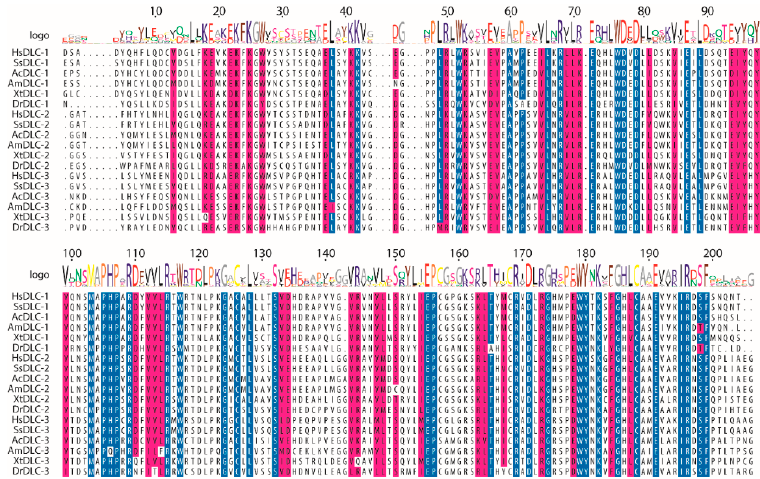
Figure 2. Representative subset of the multiple sequence alignment (MSA) of StAR-related lipid transfer (START) domains from DLC-1, DLC-2, and DLC-3 orthologs. Species include Homo sapiens (Hs), Sus scrofa (Ss), Aquila chrysaetos (Ac), Alligator mississippiensis (Am), Xenopus tropicalis (Xt), and Danio rerio (Dr). Blue indicates residues that are identical in ≥ 98% of sequences. Magenta indicates residues with similar physiochemical properties in ≥ 98% of sequences. White represents non-conserved residues. Logo represents the consensus residue(s) of the 123 sequences used in the full alignment (see Figure S1).